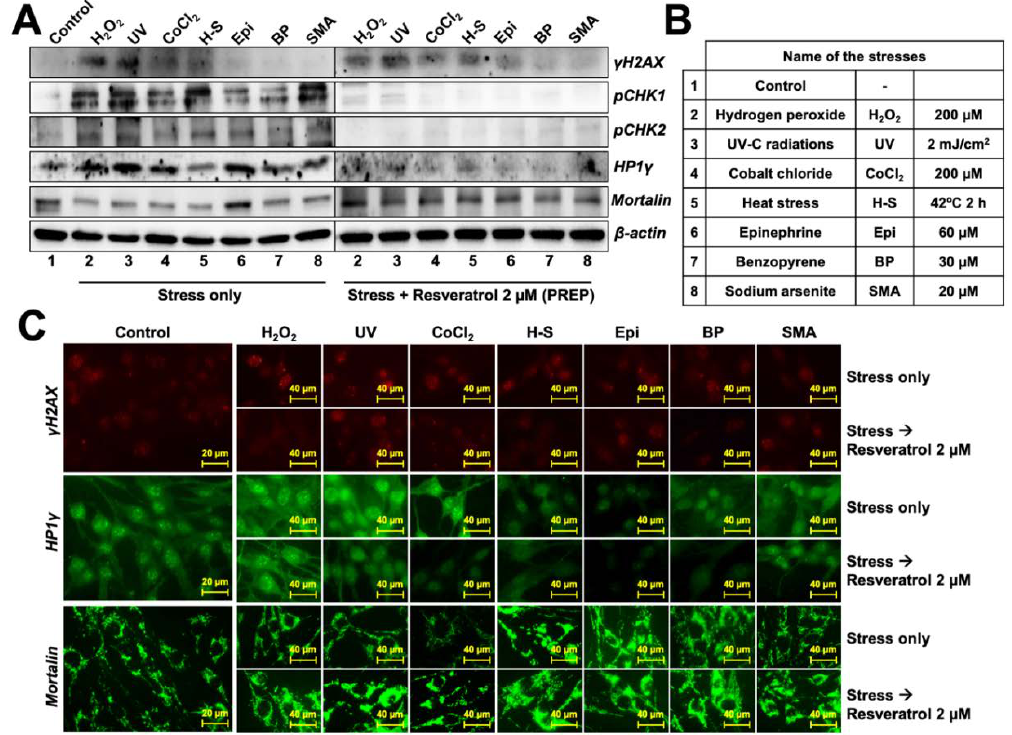
Figure 5. Molecular changes in control and resveratrol-treated stressed cells. ( A ). Western blot showing induction of DNA damage signaling and growth arrest with various chemical stresses listed in ( B ). Resveratrol-treated cells showed considerable reversal of the molecular changes. ( C ). Immunostaining showing induction of DNA damage ( γ H2AX) and senescence (HP1 γ ) in stressed cells. Resveratrol-treated cells showed considerable recovery. The decrease in mortalin in cells stressed with some stresses was recovered with resveratrol treatment.